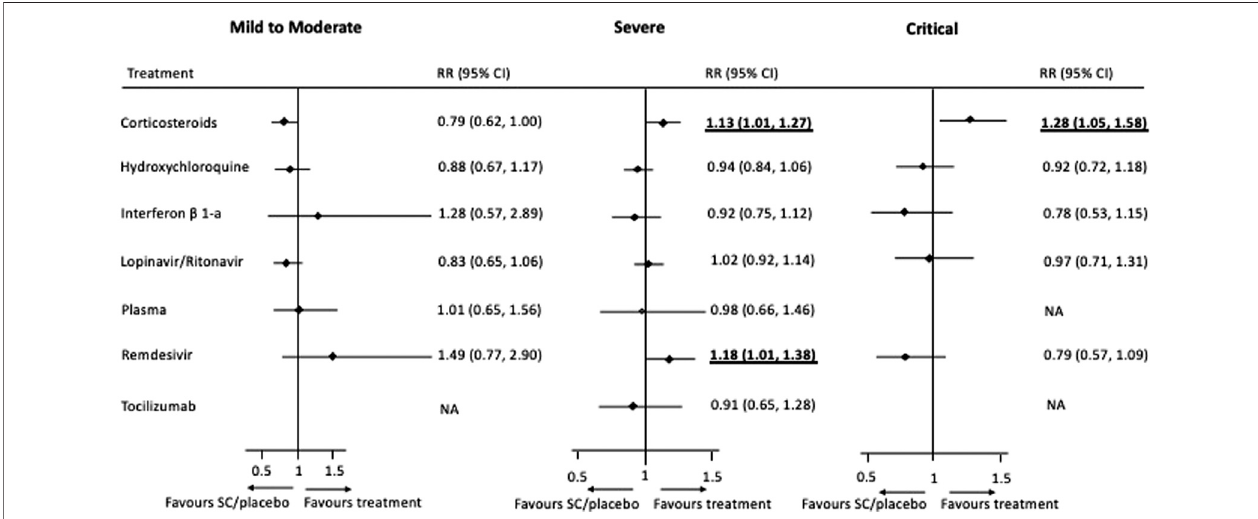
FIGURE4 | Forest plots ofnetwork meta-analysisbysubgroup fordisease severity:Mild toModerate (17 trials), Severe (21 trials), and Critical (9 trials). Treatments are compared for each treatment to standard care or placebo, and performed for treatments with > 100 individuals